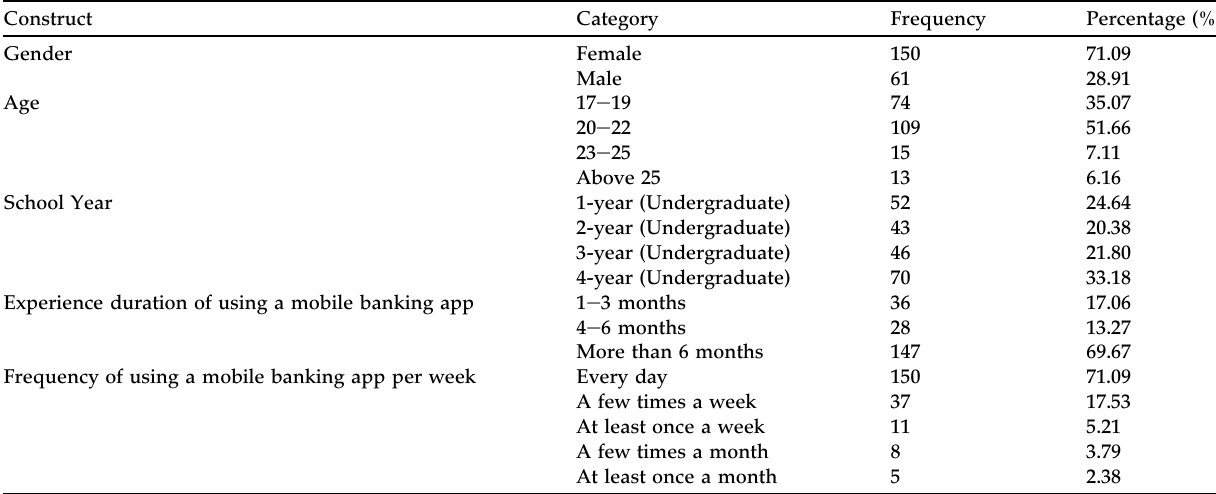
Table 1. Sample demographics description.